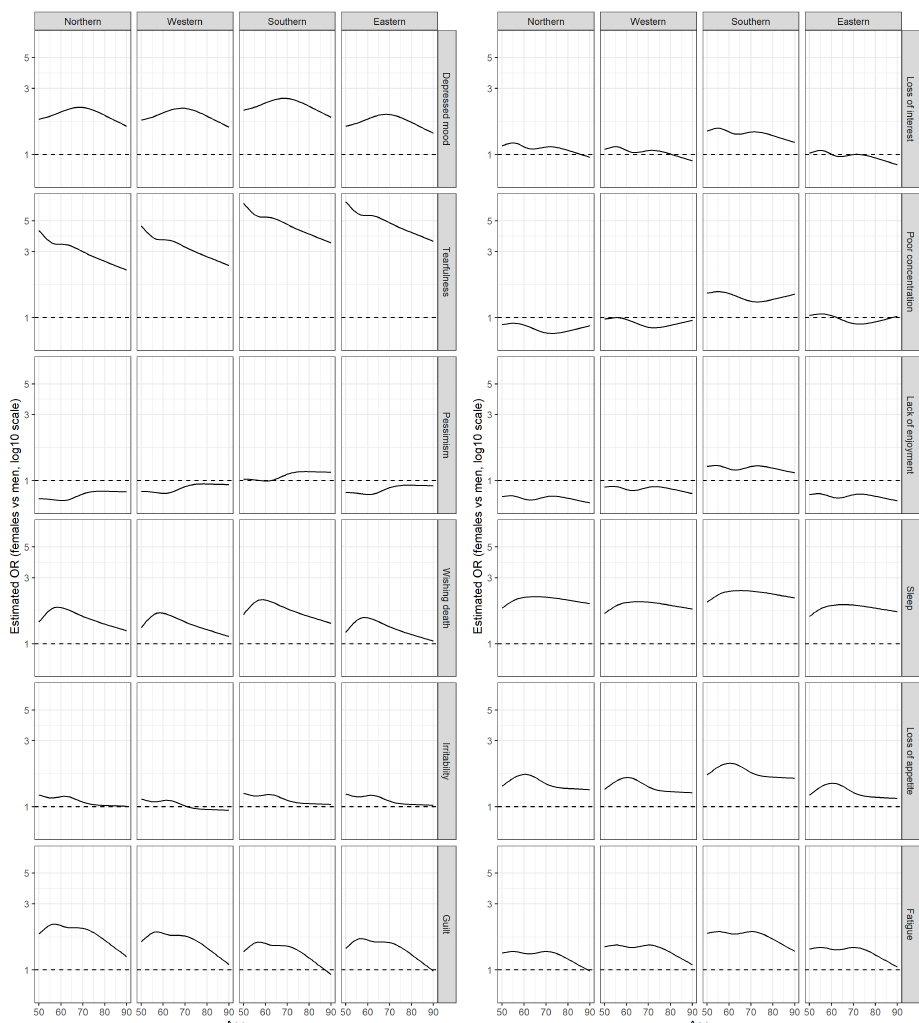
Figure A3. Estimated OR for females versus males for symptoms, by age and region. Estimates were obtained with from logistic regression models including two-way interactions between age, sex and region (base model) and additional risk factors (education, BMI, current smoking, presence of chronic disease, vigorous physical activity, living arrangement; adjusted model); age was modelled using restricted cubic splines (rcs). See Table 3 for sample sizes within each region and by sex, and for descriptive